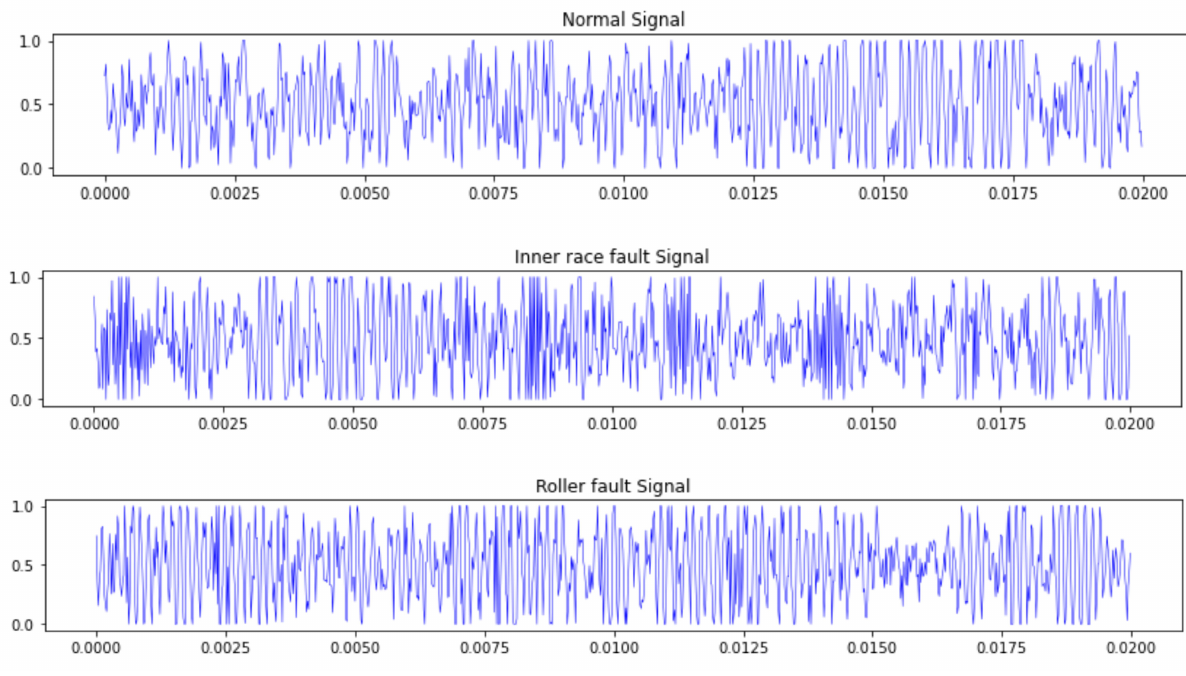
Figure 7. The original bearing vibration signals of different fault classes. Table 1. The training/validation/testing data statistics of rolling